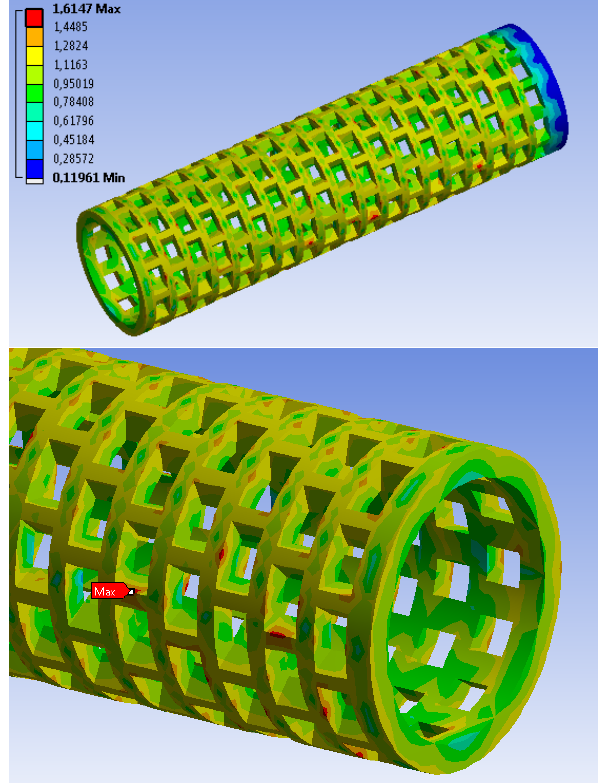
Figure 19. Stress distribution in the implant.